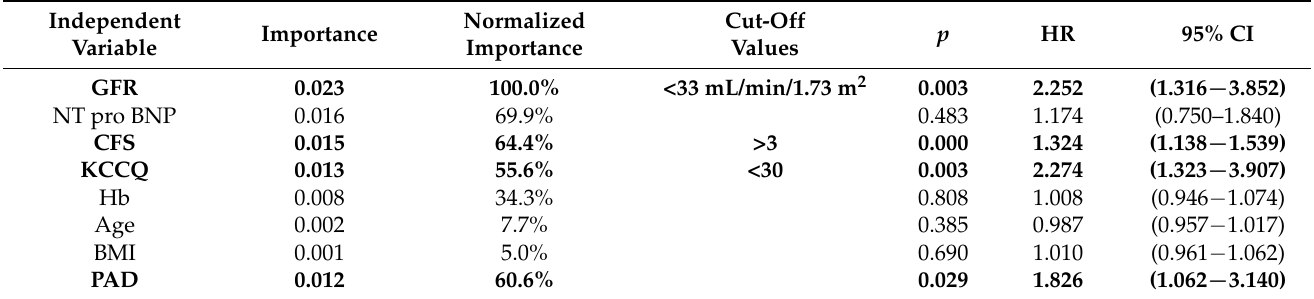
Table 2. DTA and binary regression analysis for LoS.